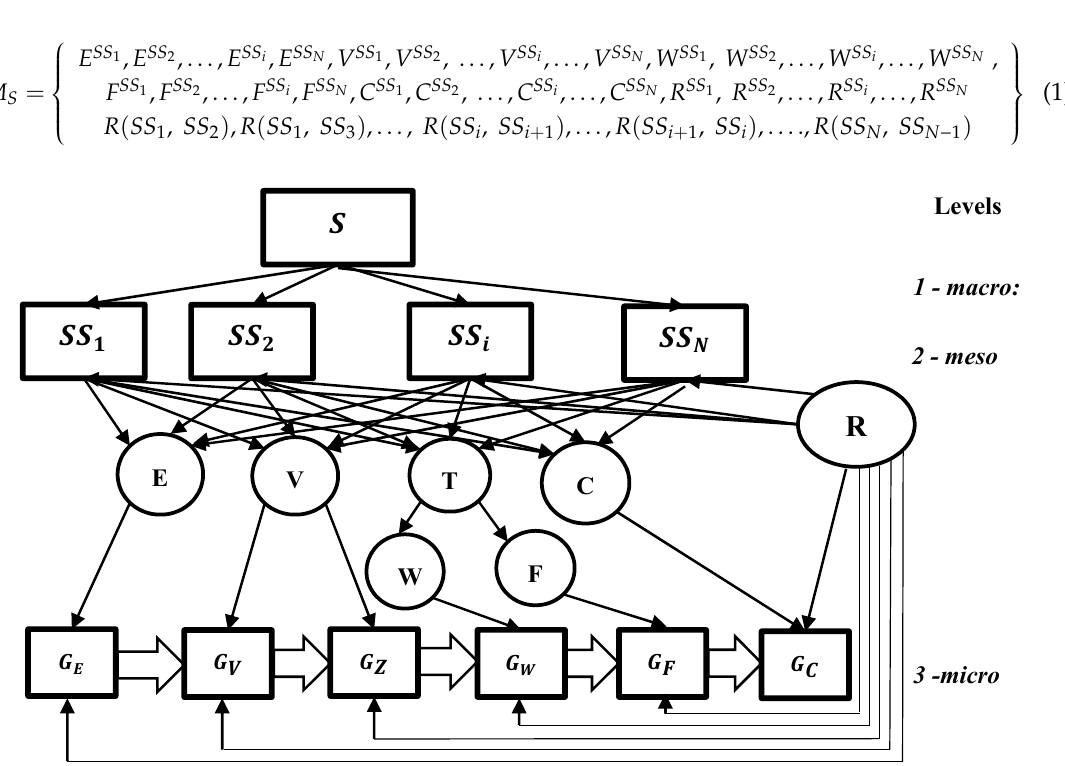
Figure 1. G raph of the decomposition of IS.